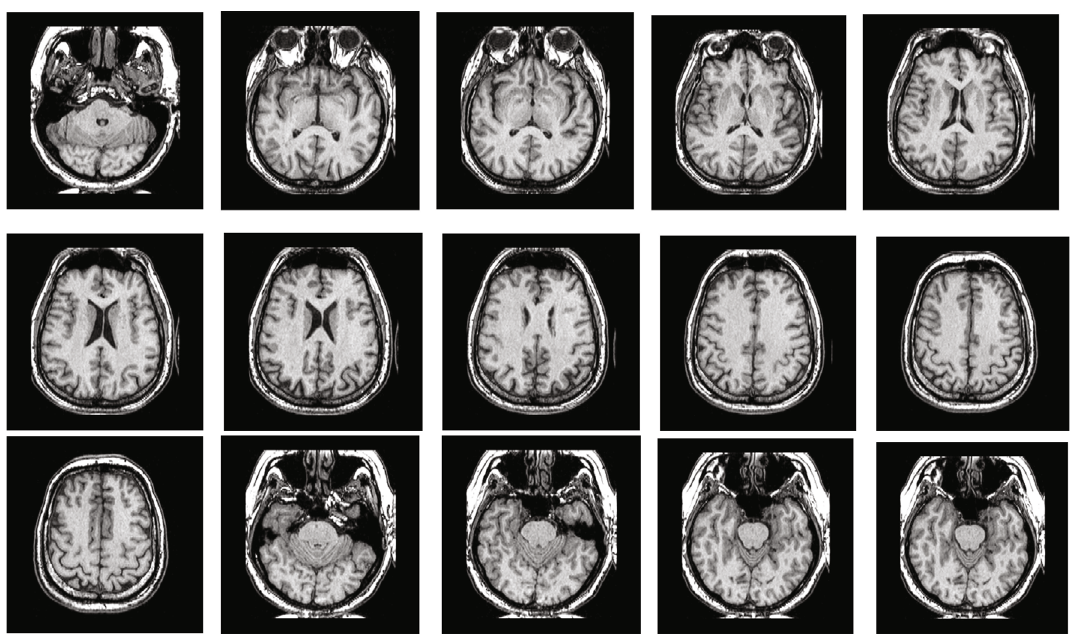
Figure 8: Sample MRI images from the